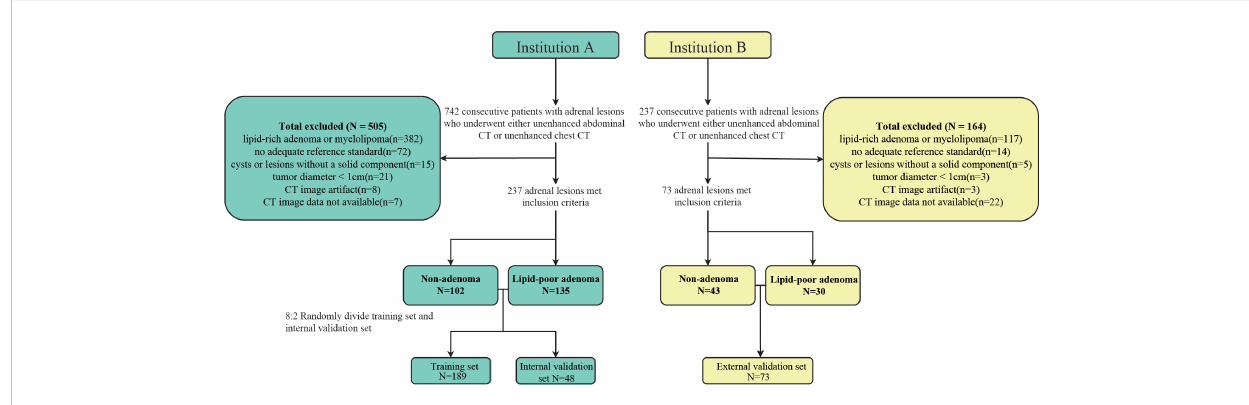
FIGURE 1 Flowchart of sample inclusion and exclusion in this